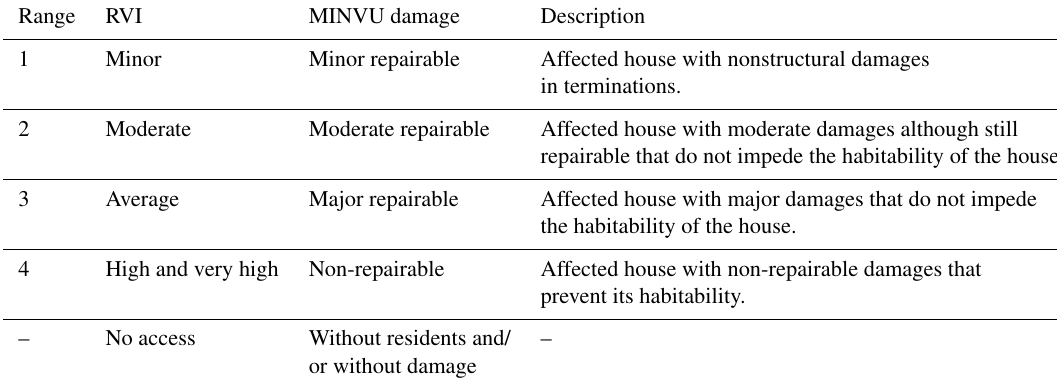
Table 5. Established ranges for RVI and actual damage